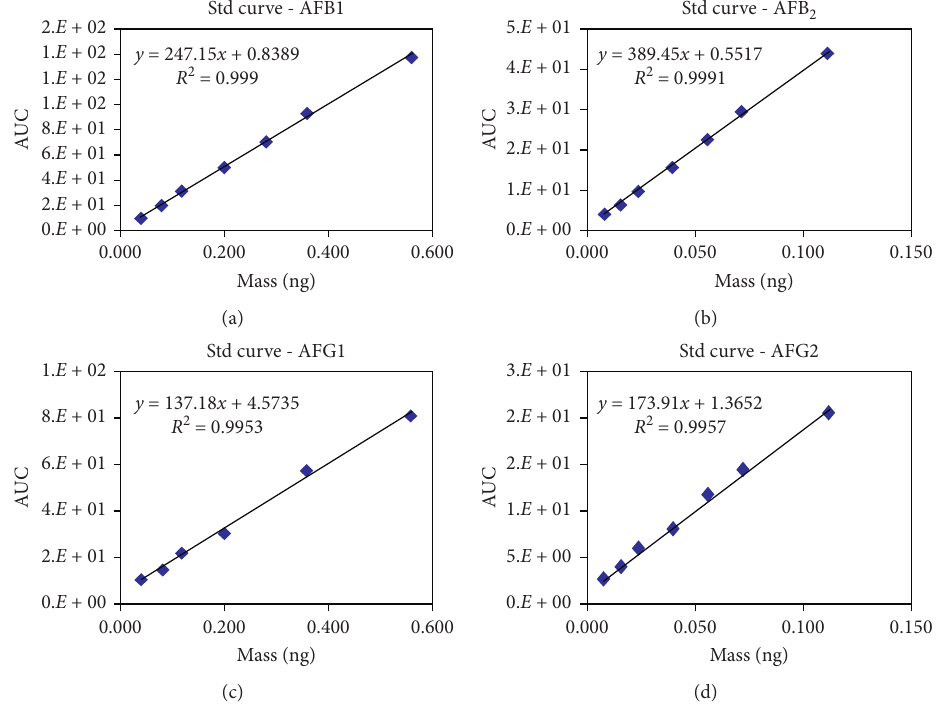
Figure 1: Standard curve of AFB1 (1), AFB2 (2), AFG1 (3), AFG2 (4). Table 1: Validation parameters for the HPLC determination of AFB1, AFB2, AFG1, AFG2, and OTA. Validation